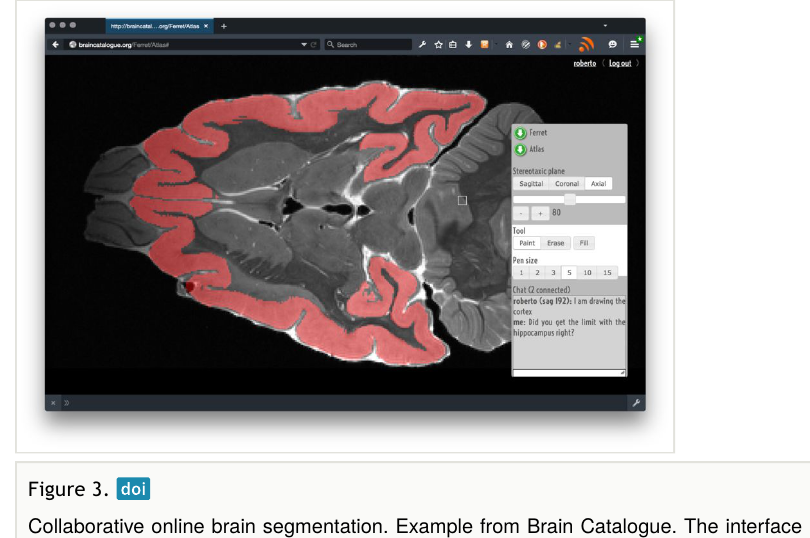
Figure 3. Collaborative online brain segmentation. Example from Brain Catalogue. The interface allows users to interact in real time to segment MRI data (here, segmentation of the neocortex). Users see each other working, and can discuss via chat.